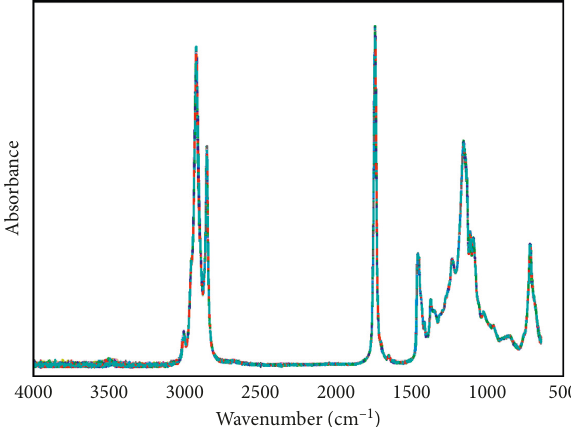
Figure 3: FTIR spectra of 17 different olive oil